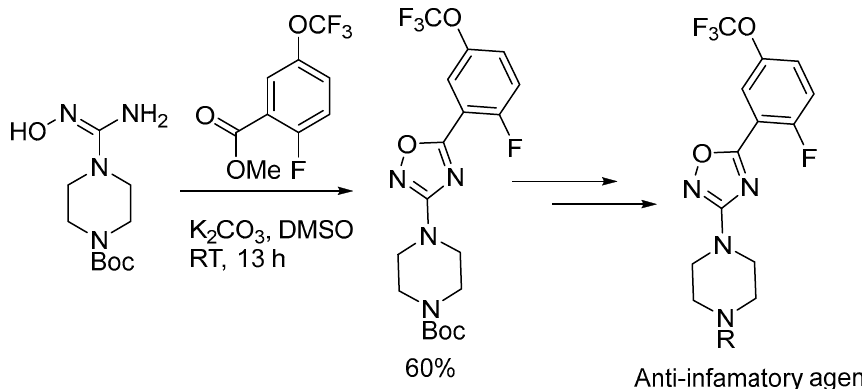
Scheme 16. Synthesis of anti-in fl ammation agents based on the 1,2,4-oxadiazol-3-yl)piperazine sca ff old. Recently, Boyarskiy with coworkers reported that the reaction between amidoximes and maleic esters in NaOH/DMSO medium provided 1,2,4-oxadiazin-5(6 H )-ones instead of the expected 1,2,4-oxadiazoles (Scheme 17). The base replacement to t -BuONa and increasing the amidoxime amount up to 2.5 eq allowed them to obtain hybrid 3-(aryl)-6-((3- (aryl)-1,2,4-oxadiazol-5-yl)methyl)-4 H -1,2,4-oxadiazin-5(6 H )-ones [112].